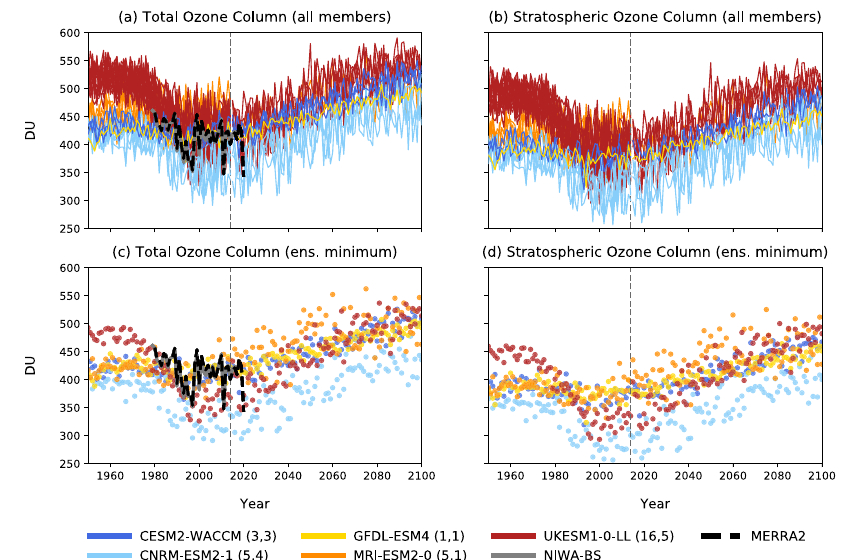
Fig.1|ArcticcolumnozoneinMarch,in fi veCMIP6modelsunderSSP5-8.5,and in observations. The top panels ( a , b ) show all the members of our multi-model ensemble, and the bottom panels ( c , d ) the minimum over that ensemble. The left panels ( a , c ) showthe total ozone column, the right panels ( b , d ) the stratospheric columnalone.Fortheperiod1950 – 2014wehaveplottedthehistoricalsimulations;